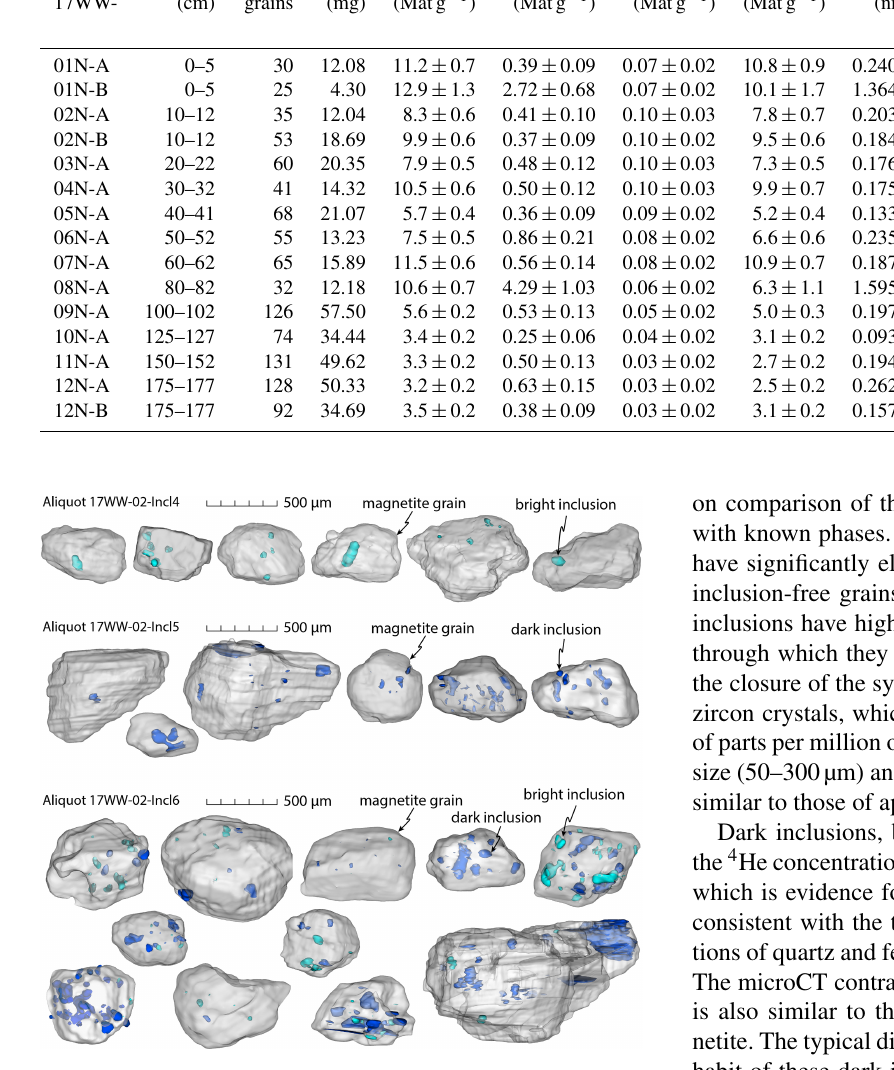
Figure 8. Segmented volume renderings of magnetite grains with many bright (turquoise) and dark inclusions (dark blue) constructed from microCT data. These are all of the grains from aliquots 17WW-02-Incl4 (many bright inclusions), 17WW-02-Incl5 (many dark inclusions), and 17WW-02-Incl6 (many bright and dark inclu- sion); for helium data see Table